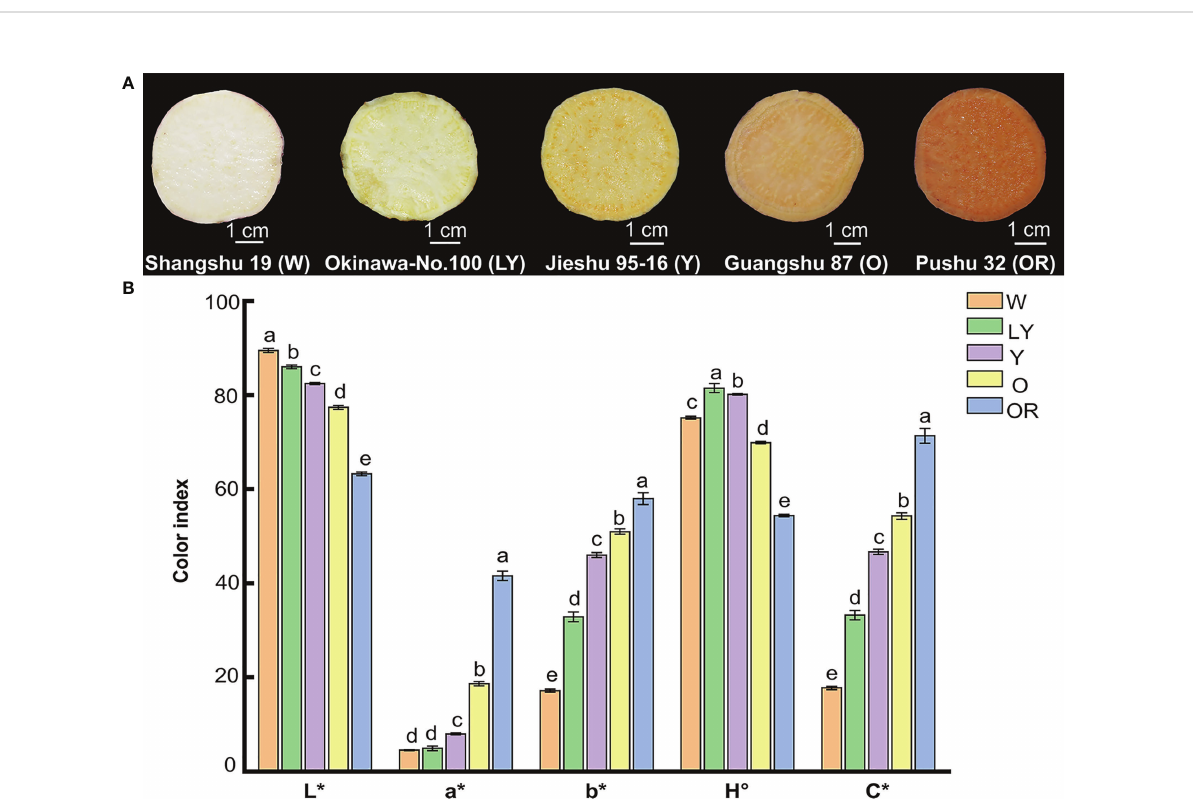
FIGURE 1 Phenotypic characteristics and color parameters of fi ve sweetpotato fl eshes. (A) Flesh color of fi ve cultivars. Shangshu 19, Okinawa-No.100, Jieshu 95-16, Guangshu 87, Pushu 32 cultivars were renamed as W, LY, Y, O, OR, respectively. (B) The color indexes (L*, a*, b*, H°, C*) of fi ve sweetpotato fl eshes. Lowercase letters a, b, c, d and e represent signi fi cance at p ≤ 0.05. Error bars represent mean ± SD (n =